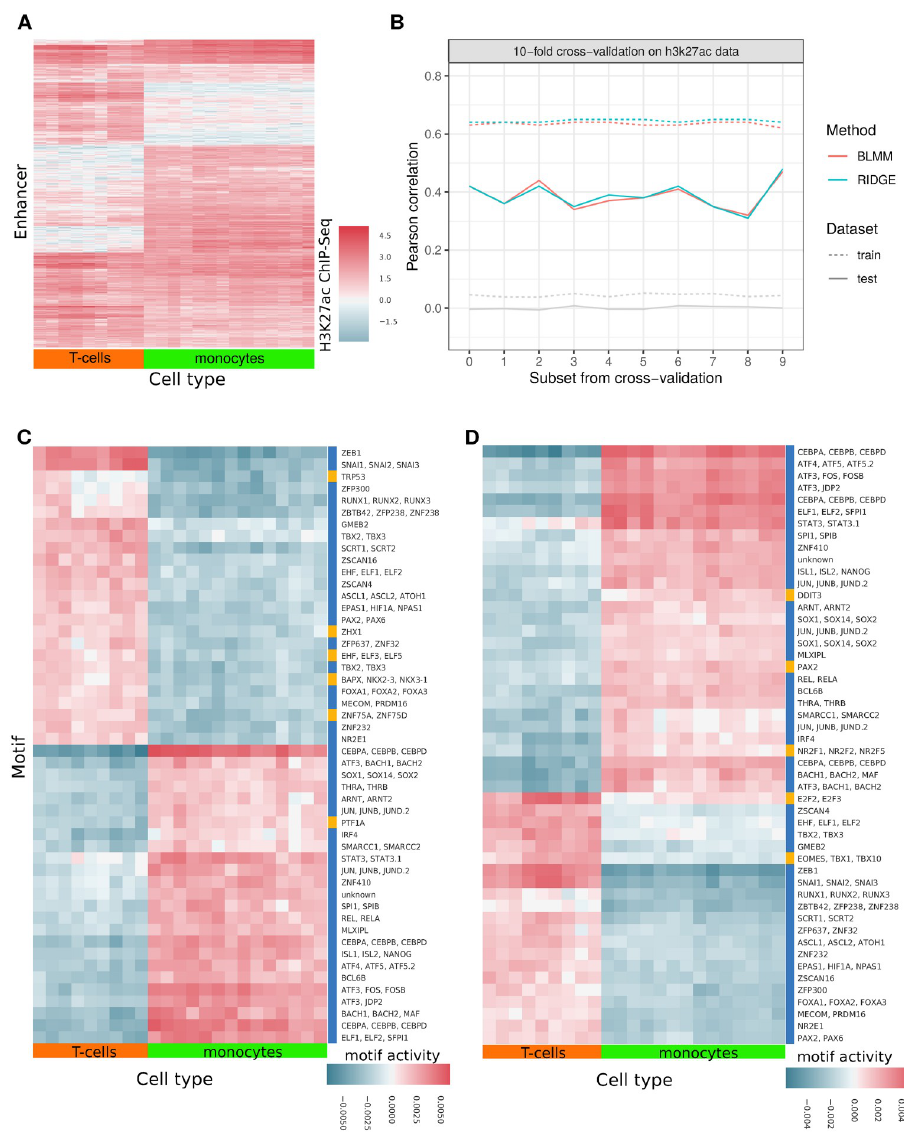
Fig 3. Data application on H3K27ac data. (A): Pattern of H3K27ac ChIP-seq signal in putative enhancers over two hematopoietic cell types, T cells and monocytes. (B): Pearson correlation between training set and predicted ChIP-seq signal on training set and between test set and predicted test ChIP-seq signal of a ten-fold cross-validation. In gray, the mean Pearson correlation between predicted and real signal using each method (overprinted lines show high concordance between methods), with a 1000-fold randomization of motif scores is shown. (C) and (D): Motif weights for 50 enhancers across the two cell types, assuming dependence (C) or independence (D) between the conditions. Enhancers are chosen based on largest difference in mean H3K27ac ChIP-seq signal per tissue group. Common motifs of Bayesian Linear Mixed Model (C) and Ridge Regression (D) are depicted in blue, others are depicted in yellow.